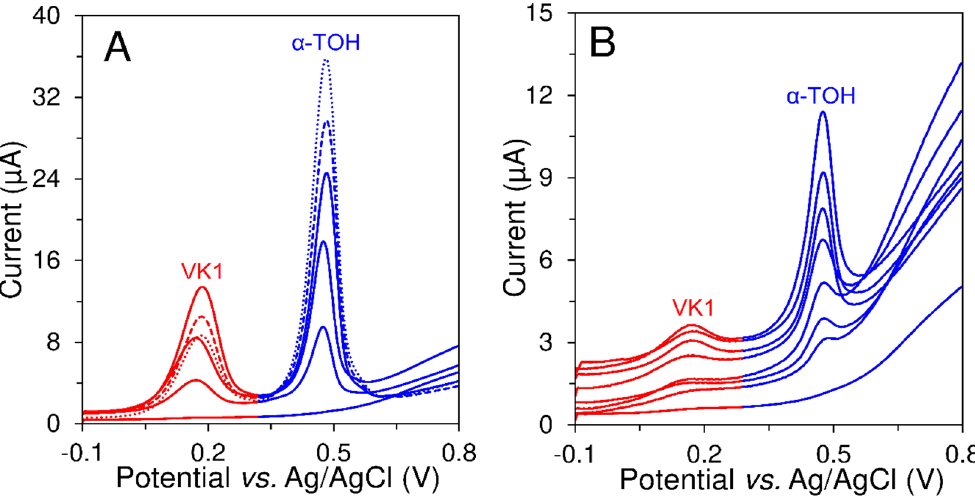
Figure 4. SWAdSV voltammograms of calibration curves of VK1 and α -TOH at optimized working conditions: ( A ) 0 (blank), 2, 4, 6, 8 (dashed) and 10 (dotted line); ( B ) 0 (blank), 0.05, 0.1-, 0.2-, 0.4-, 0.6-, 0.8- and 1.0- µ mol L − 1 VK1 and α -TOH.